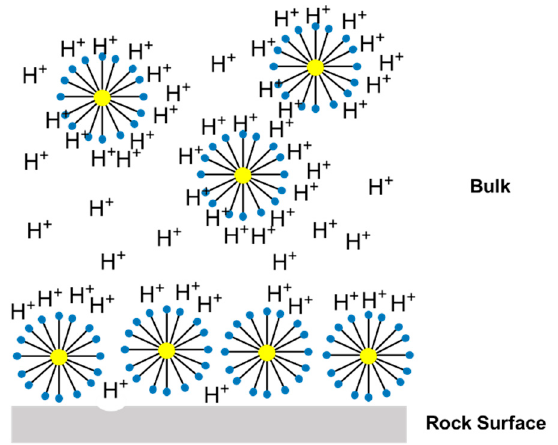
Figure 12. Consumption of calcium carbonate with time.